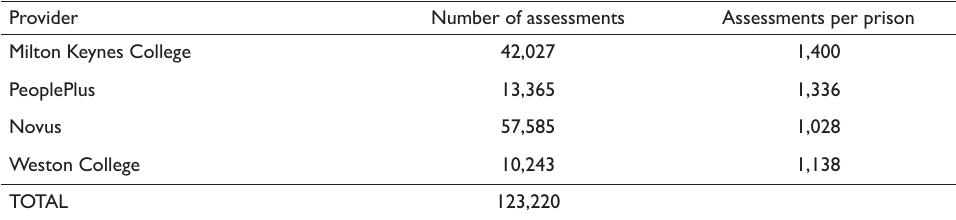
Table 4: Numberofassessmentsbyprovider